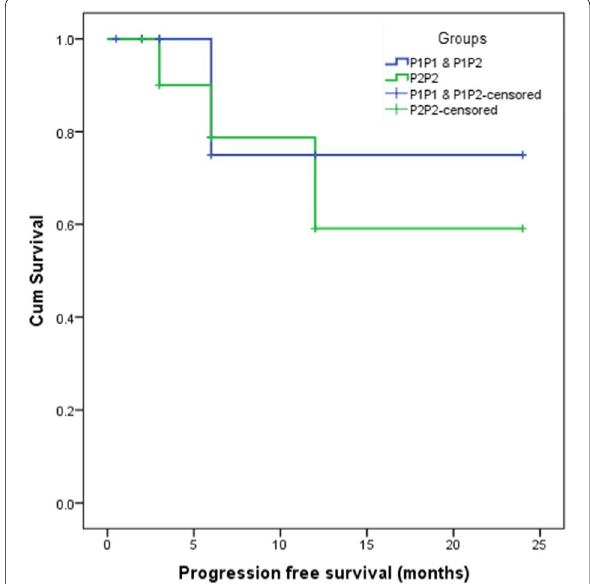
Fig. 2 Kaplan–Meier curves of DFS of patients with P2P2 (59.10%) (green line) and patients with P1P1 and P1P2 (75%) (blue line) after 12 months of